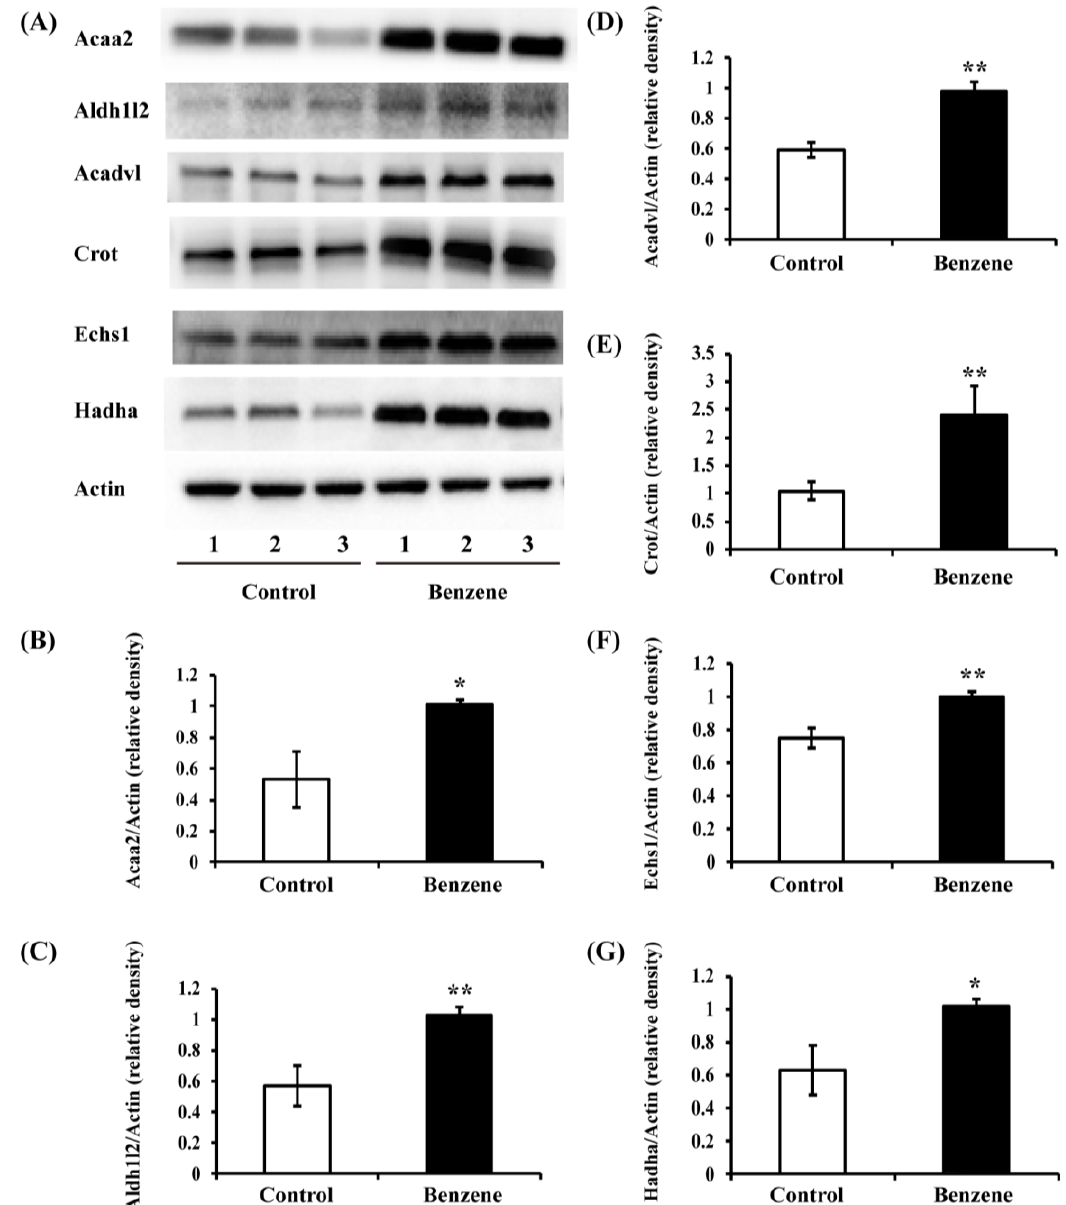
Figure 4. Benzene induces increased expression of key FAO proteins in mouse BM cells. Male C3H/He mice were exposed to benzene for 4 weeks, and BM cells were collected. Then, Acaa2, Aldh1l2, Acadvl, Crot, Echs1, and Hadha protein levels were detected by Western blot ( A ). The relative expression of Acaa2 ( B ); Aldh1l2 ( C ); Acadvl ( D ); Crot ( E ); Echs1 ( F ); and Hadha ( G ) was calculated by densitometric scanning of band intensity. Values are mean ± SD; compared with control group: * p < 0.05; ** p < 0.01.